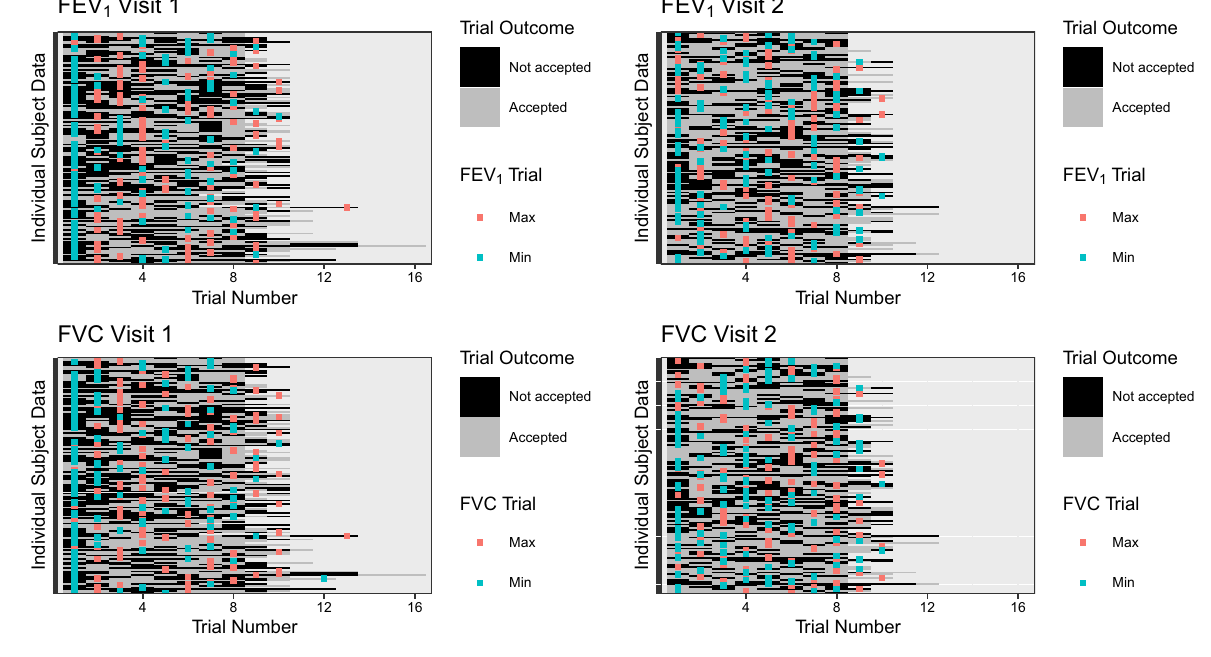
Figure 1. Heat map diagram illustrating the minimum and maximum forced expiratory volume in one second (FEV 1 ) and forced vital capacity (FVC) vs. trial outcome (accept/not accept) for each visit and subject. Data are displayed across the vertical axis for each individual subject. The outcomes for every subject’s attempted trial (accepted vs. not accepted) are represented by the black and grey boxes with trial number indicated on the horizontal axis. The absolute maximum and minimum value for each subject’s FEV 1 and FVC measurement are indicated with a red and blue marker, respectively.